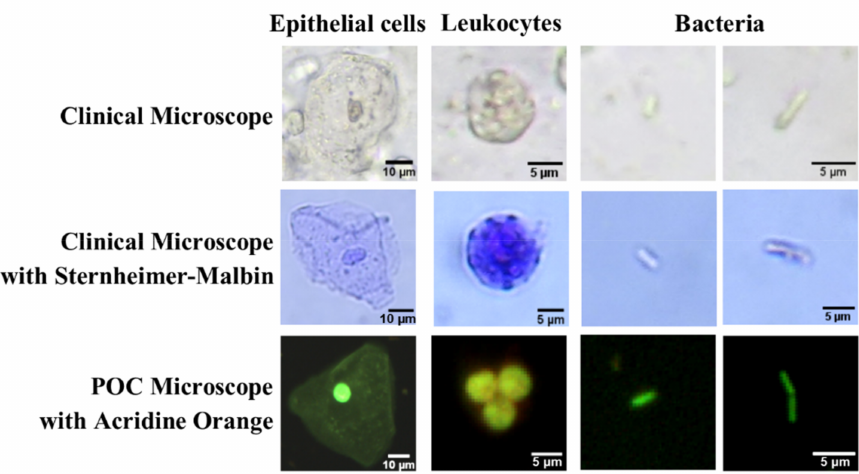
Figure 2. Qualitative comparison between the clinical system using phase contrast (row 1), clinical system using Sternheimer–Malbin dye (row 2), and the point-of-care (POC) system using acridine orange (row 3). Epithelial cells, leukocytes, and bacteria demonstrate the di ff erences between the systems. Scale bars represents 10 µ m for epithelial cells, and 5 µ m for leukocytes and bacteria. Images enhanced for